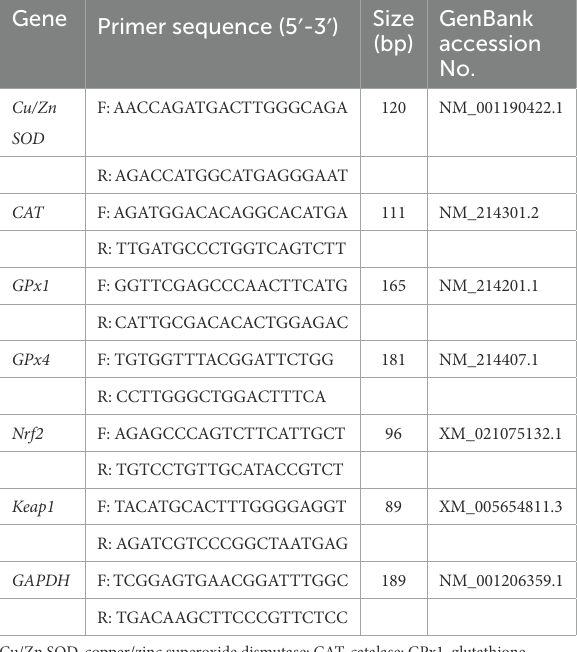
TABLE 2 Primer sequences for real-time PCR